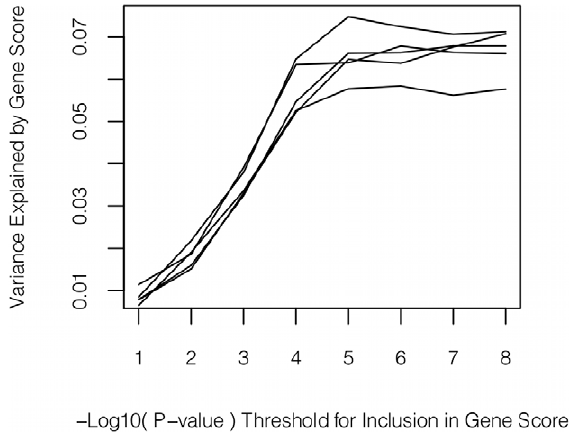
Figure 3. Polygene analysis. Variance explained (adjusted R 2 ) by gene scores using varying P-value thresholds for inclusion of SNPs. Each P-value threshold was tested 5 times using a 5-fold cross-validation procedure.